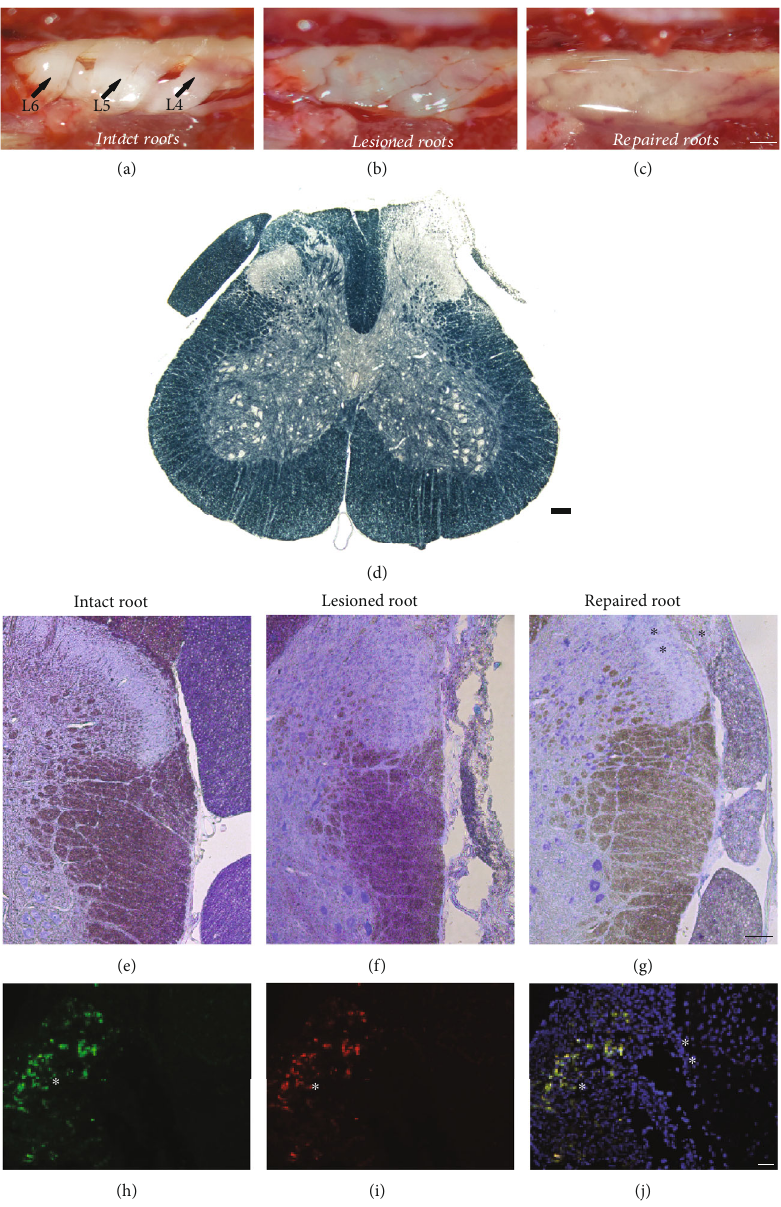
Figure 2: (a – c) Region of lumbar intumescence of an injury in a rat, seen through a surgical magnifying loupe. (a) Intact dorsal roots (L4, L5, and L6). (b) Transected dorsal roots (L4, L5, and L6). (c) PRP gel on the transected dorsal roots (L4, L5, and L6), immediately after its application. Immediately after applying the gel, it started to polymerize. From then on, it was no longer possible to reposition the roots that were transected on the spinal surface. Therefore, the repositioning of the roots after injury must be accurate before applying the gel. It is also possible to observe some hemorrhage after the lesion induction, where it was stopped with the gel. Scale bar = 5mm . (d) Representative photomicrograph of transverse sections of the spinal cord stained with Sudan black 8 weeks after DRZ. The lesioned ipsilateral root was completely degenerated, as opposed to the contralateral root, which exhibits high integrity. Scale bar = 100 μ m . (e – g) Photomicrograph of transverse sections of the hemispinal cord stained with toluidine blue, 8 weeks after the DRZ. (e) The unlesioned root showed a large number of axons. (f) The lesioned root was completely disrupted. (g) The repaired root showed a signi fi cant number of axons. Scale bar = 100 μ m . (h – j) Bioengineered human embryonic stem cells (hESCs) found in the roots repaired with PRP, two weeks after injury: (h) hESCs overexpressing FGF2 (GFP+), in green; (i) hESCs marked with an antibody speci fi c for human mitochondria (hMito), in red; (j) merge: GFP+ (green) + hMito (red), demonstrating that the engrafted cells are in fact the modi fi ed bioengineered hESCs. In blue, nuclear DNA labeling was performed using DAPI. ∗ Repaired root . ∗∗ Spinal cord . The cells remained in the replanted root. Scale bar = 20 μ m